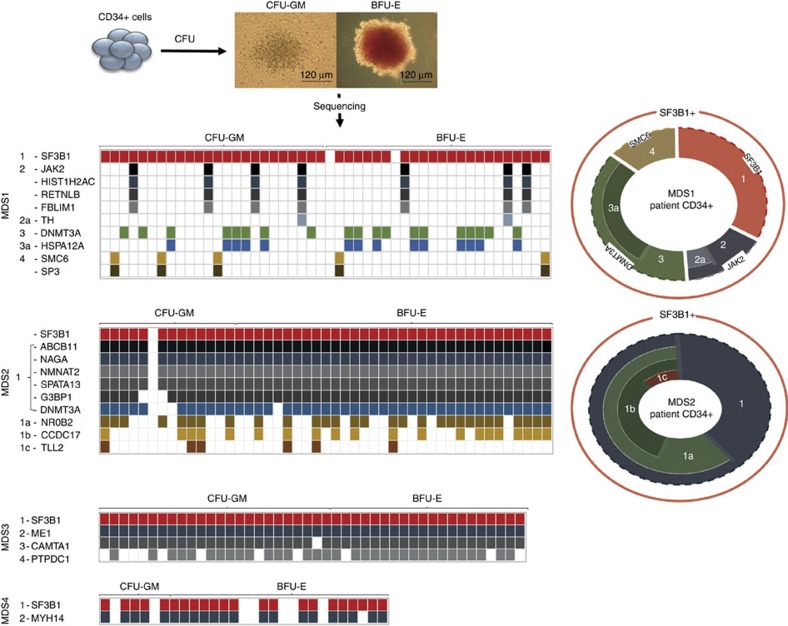
SF3B1 mutations in single-cell colonies.Mutational analysis was performed on BFU-E and CFU-GM colonies derived from primary CD34+ patient cells (MDS1, MDS2, MDS3 and MDS4). Each column represents an individual CFC colony. Circle (MDS1 and MDS2) on the right is the representative of the overall clonality observed in the clonogenic assays (left) in MDS1 and MDS2 and total CD34+ cells. The outer red circle represents the total SF3B1 clone, while the inner circle depicts subclones. WT, wild type.